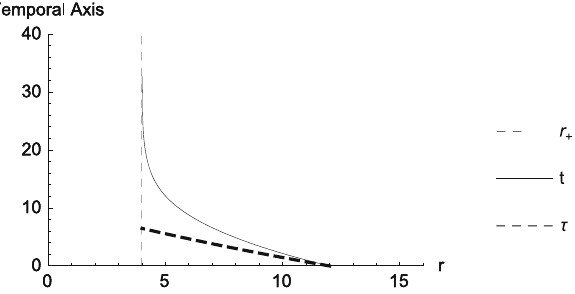
Fig. 5 The behavior of the affine ( τ ) and the coordinate ( t ) time as a function of r , with z = 100 and E = 1